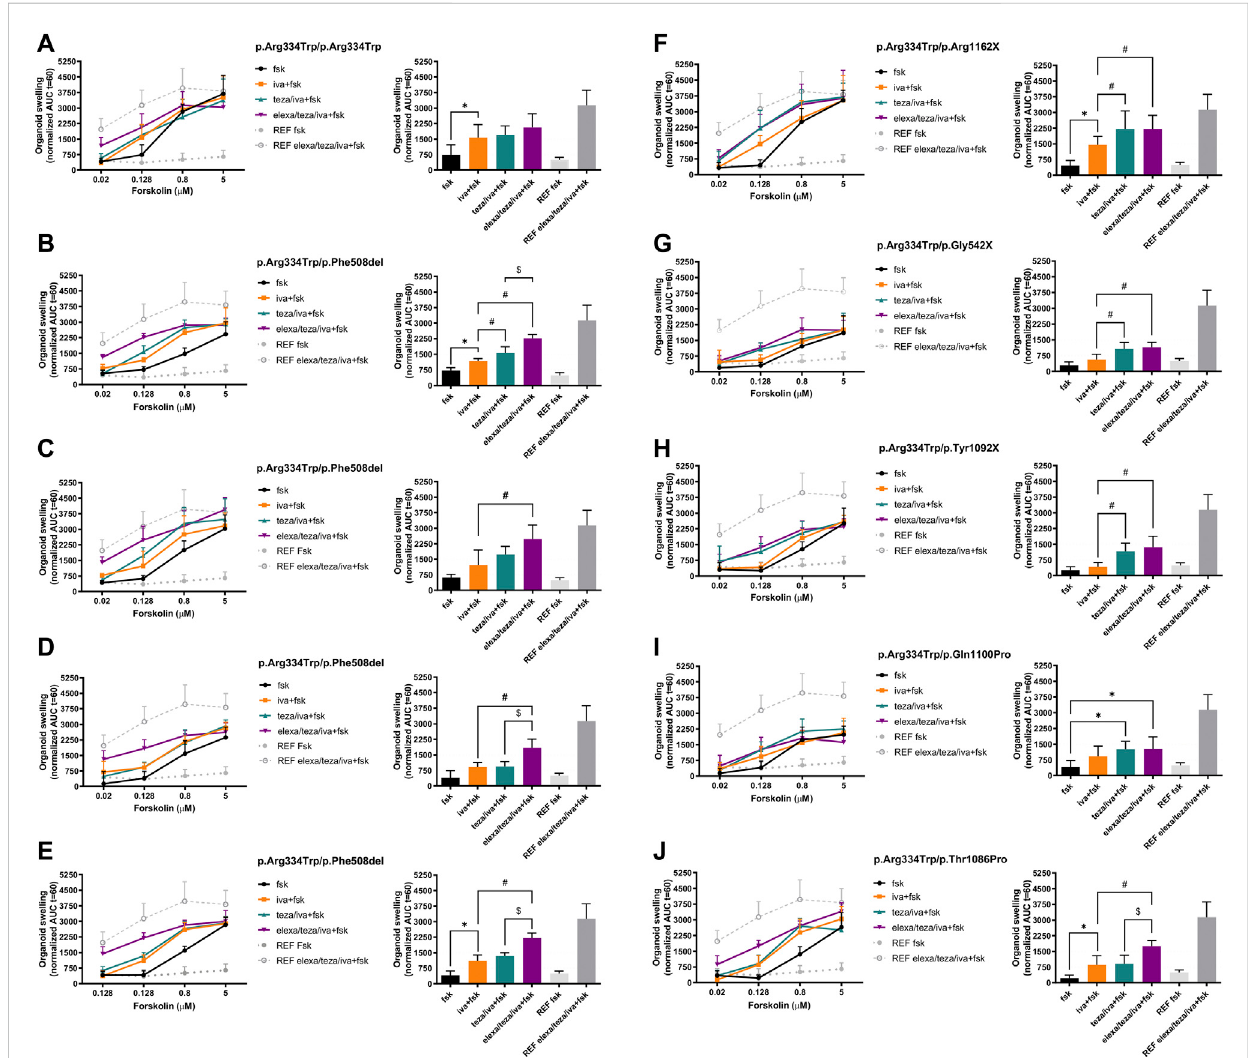
FIGURE 1 Forskolin-induced swelling (FIS) assay in intestinal organoids carrying p.Arg334Trp-CFTR. Organoid swelling is represented as area under the curve (AUC)oforganoidsurfaceareaincrease(baseline=100%,t=60 min).(Left)Organoidsweretested at0.02,0.128,0.8and5 μ MofForskolin(fsk)aloneor in combination with only iva or after 24 h-incubation with teza or elexa/teza. (Right) Swelling (AUC) quanti fi cation of the organoids at t = 60 min for stimulation with 0.128 μ M fsk alone or in combination with CFTR modulators. The p.Phe508del/p.Phe508del organoids treated with iva/teza/elexa were used as a reference for maximal CFTR rescue. Dashed green and red lines represent the established thresholds for high and medium potential clinical bene fi t for treatments, respectively. Data represent the mean ± SEM of 6 – 10 replicates per condition. Organoid genotypes are indicated above panels. Signi fi cance was considered for p -value ≤ 0.05 (ANOVA) and symbols represents signi fi cance vs.: * — stimulation with fsk alone; # — stimulation with iva + fsk; $ — stimulation with teza/iva +